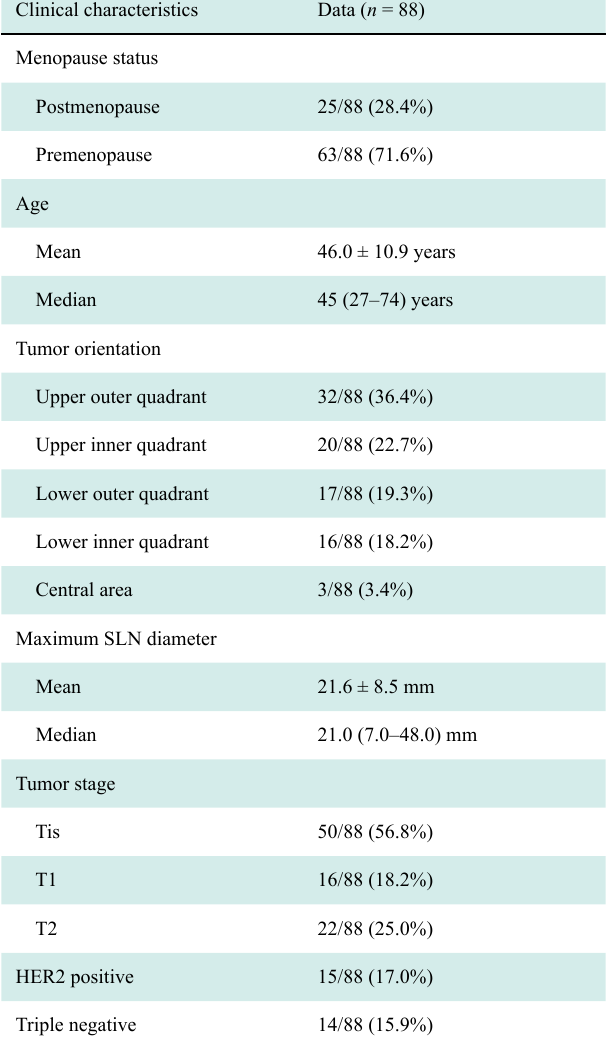
Table 1 Clinical characteristics of enrolled patients Clinical